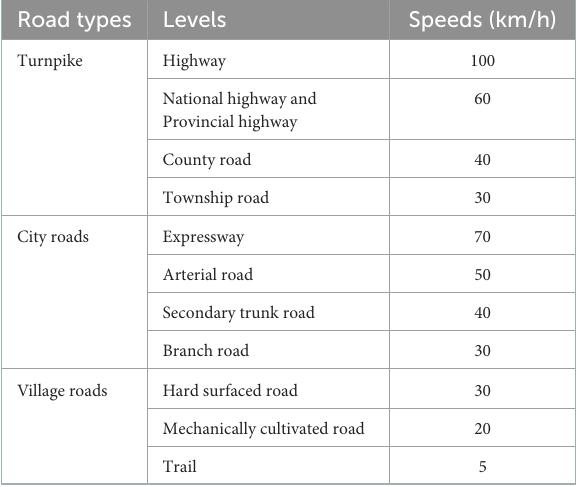
TABLE 1 Traffic speeds in Chongqing. Road